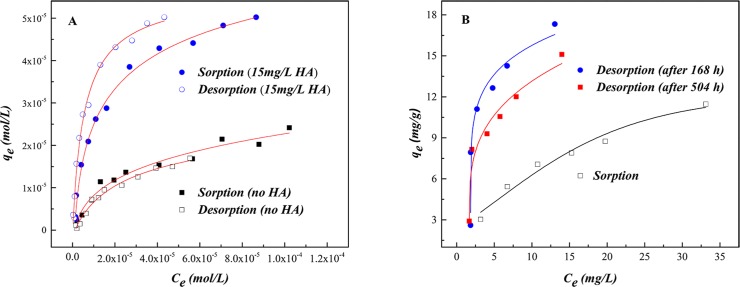
Sorption/desorption isotherms in the binary and ternary system (T = 298±1 K, I = 0.01 mol/L NaClO4, s/l = 0.6 g/L, pH = 4.5±0.1).(A) The isotherms of U(VI) on SONPs in the binary SONPs/U(VI) and the ternary SONPs/U(VI)/HA system. (B) The isotherms of HA on SONPs in the binary SONPs/HA system.